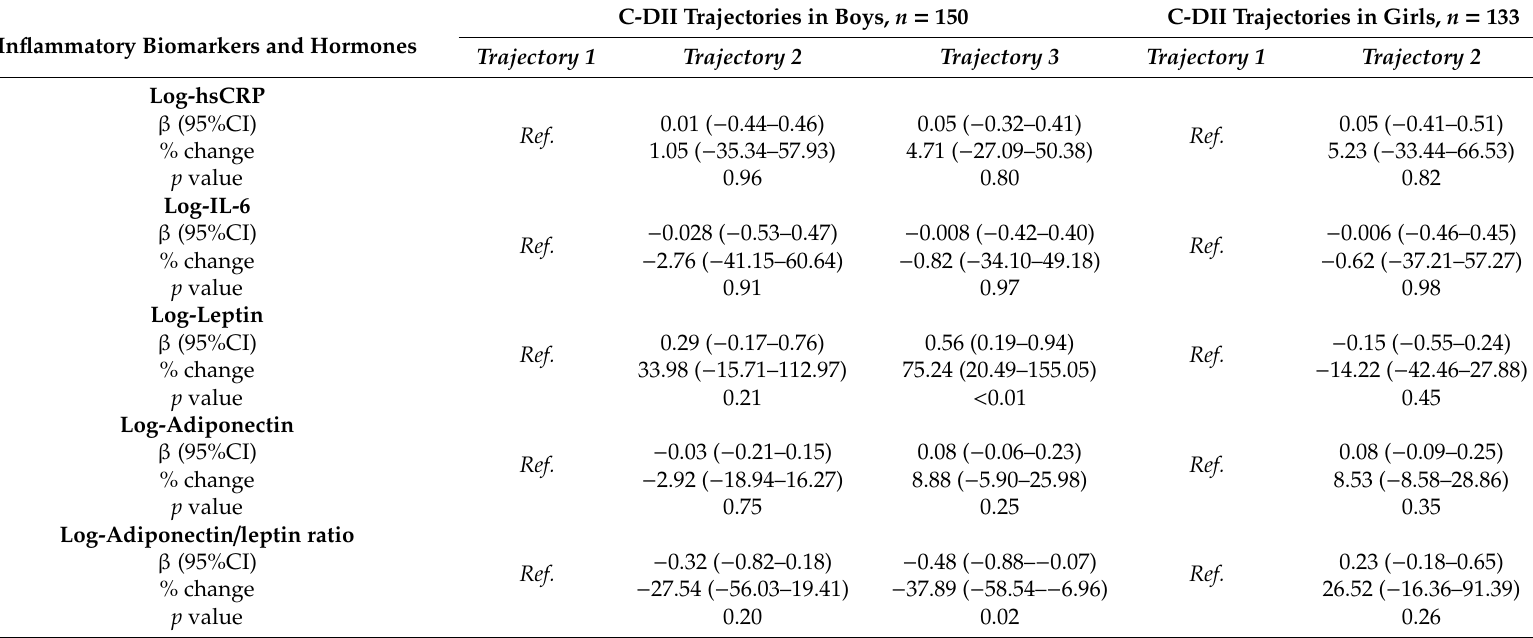
Table 4. Association between C-DII trajectories 5-11y and inflammatory biomarkers and hormones at 11 years.